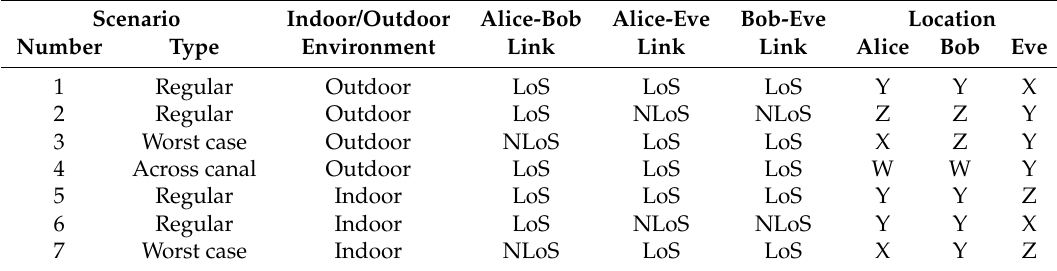
Outdoor and indoor Line-of-Sight (LoS) as well as Non Line-of-Sight (NLoS) measurement scenarios. Scenario Indoor/Outdoor Alice-Bob Alice-Eve Bob-Eve Location